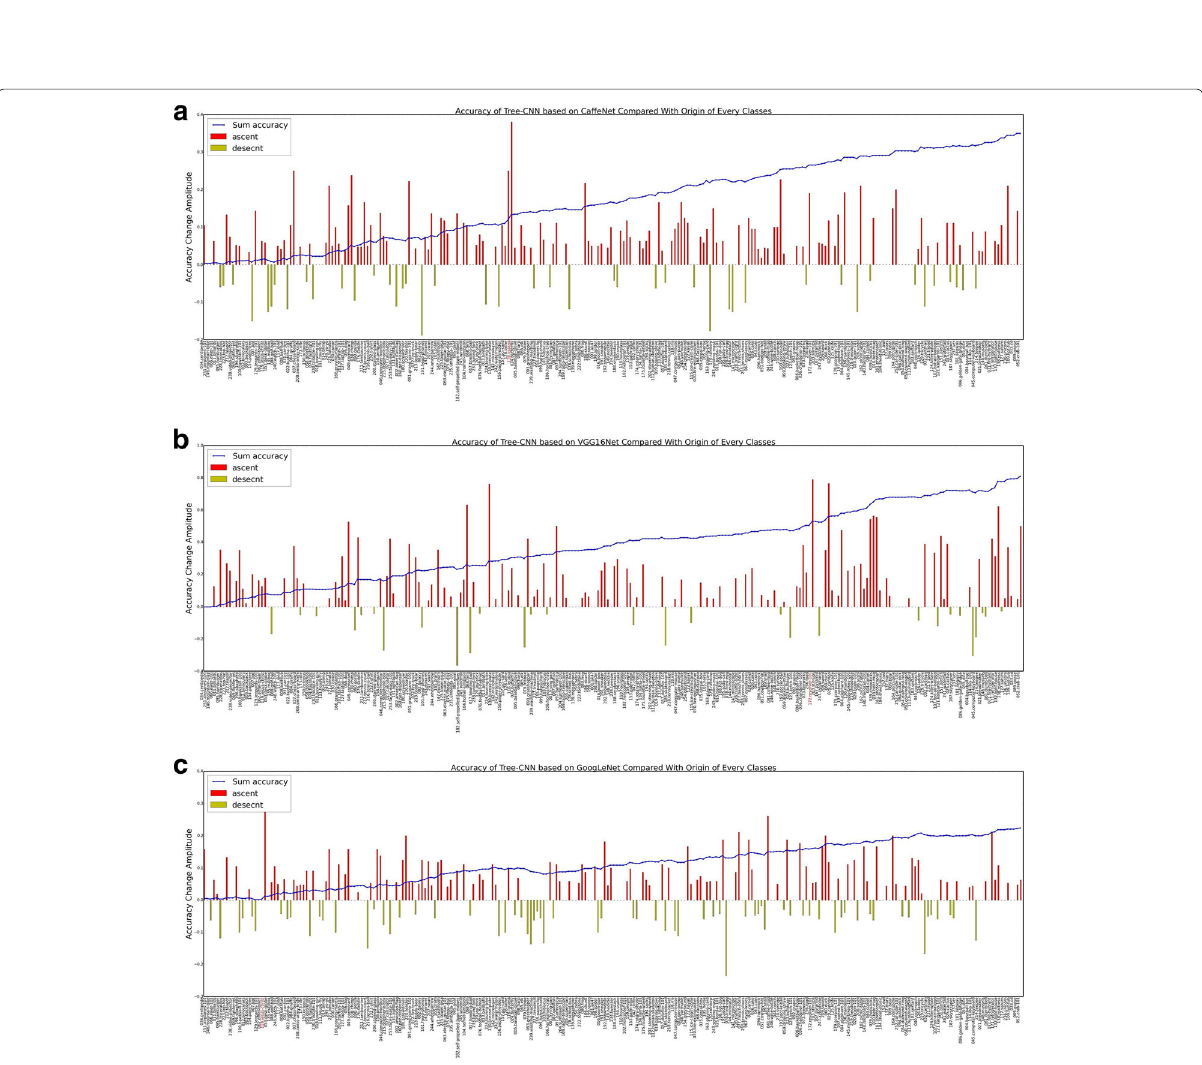
Fig. 8 The accuracy of the Tree-CNN compared with the origin of every class in Caltech256. a – c CaffeNet, VGG16, and GoogLeNet. The red bar represents the accuracy of the Tree-CNN which is higher than the original net in this category. The yellow bar represents the accuracy of the Tree-CNN which is lower than the original net in this category. The curve shows that the average accuracy variation changes with the increase in categories, and the average accuracy variation has been magnified ten